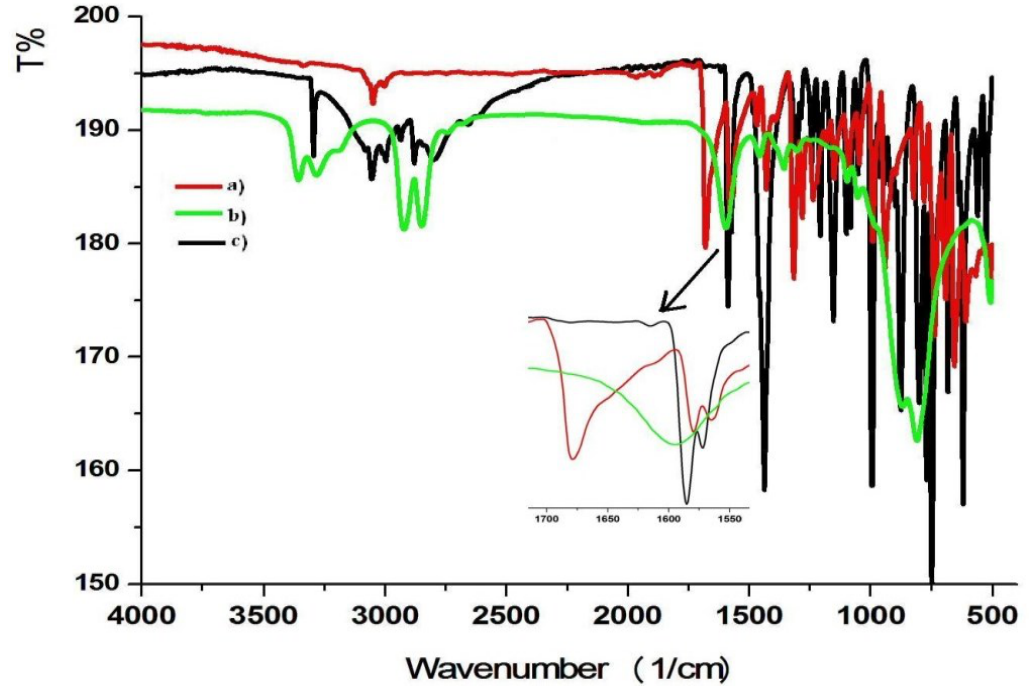
Figure 1. IR spectra of: ( a ) 2-dipyridlketone (starting material), ( b ) 2,2-dimethyl-1,3- propanediamine (starting material), and ( c ) 5,5-dimethyl-2,2-di(pyridin-2- yl)hexahydropyrimidine